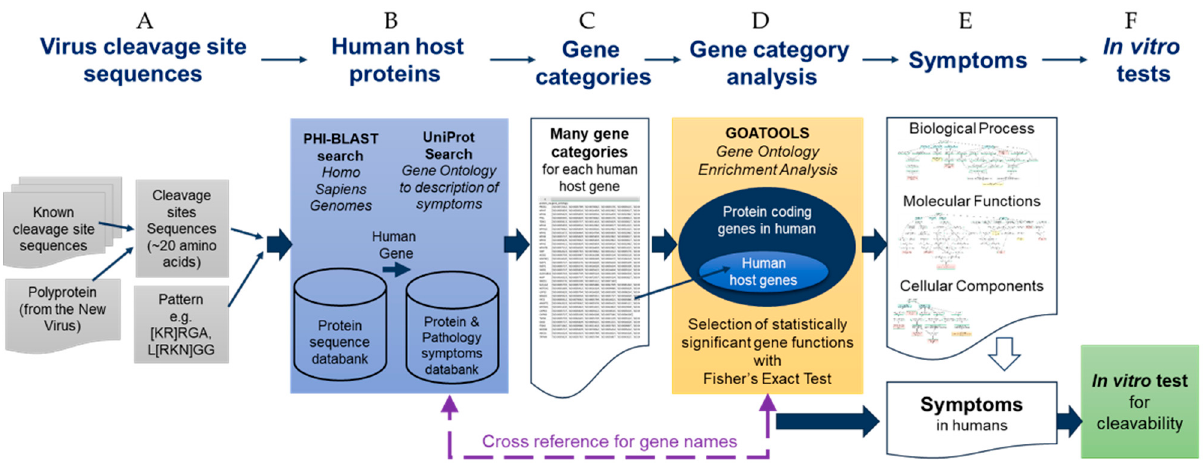
Figure 1. Schematic summary diagram of the automated SSHHPS analysis sequence-to-symptom tool with in vitro testing.